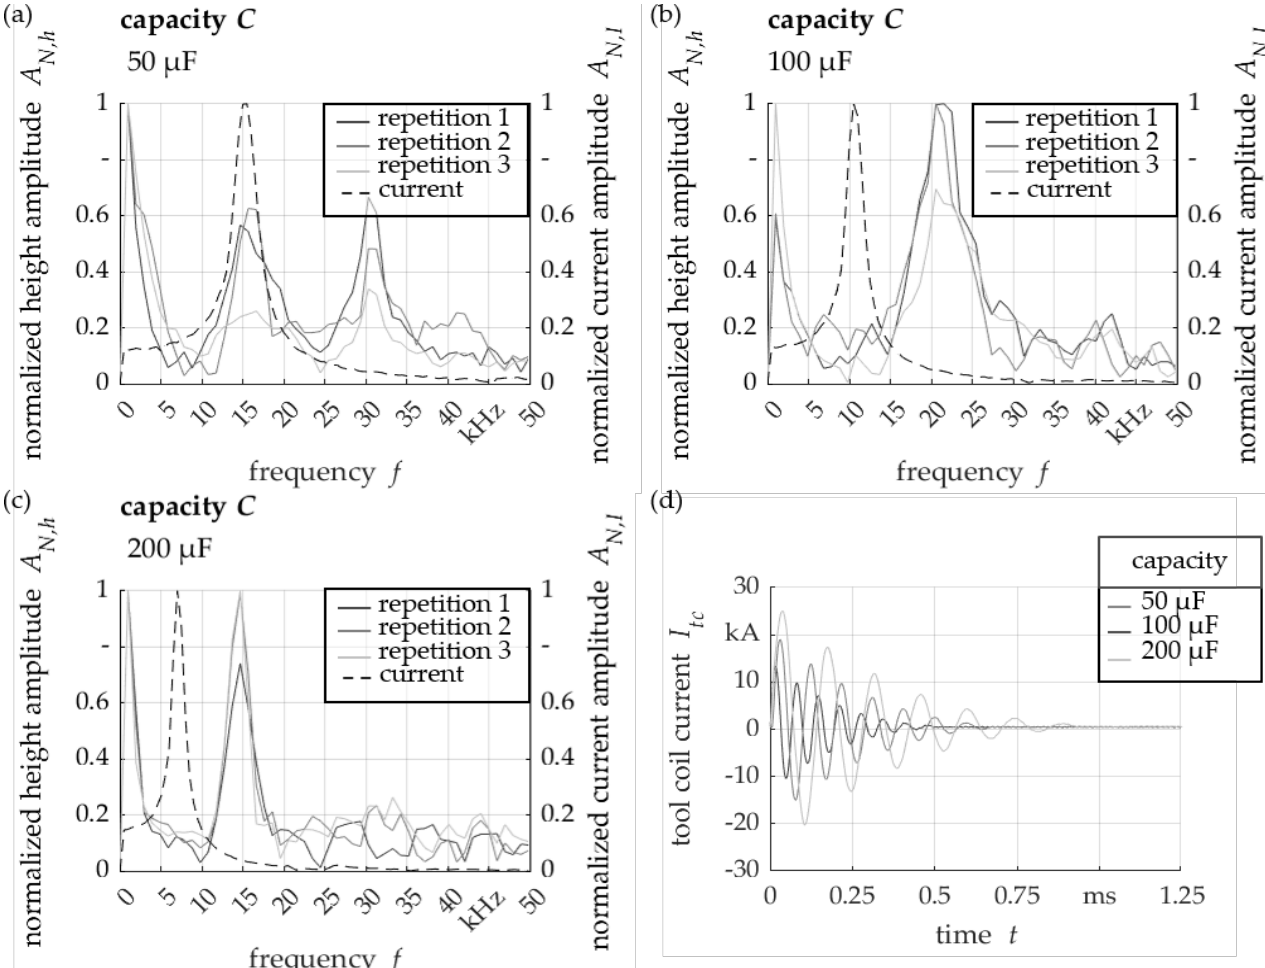
Figure 7. Effect of different capacity C on the workpiece vibration for charge voltage U 0 = 3 kV: ( a ) capacity C = 50 µF, ( b ) capacity C = 100 µF, ( c ) capacity C = 200 µF, ( d ) resulting tool coil current I tc.